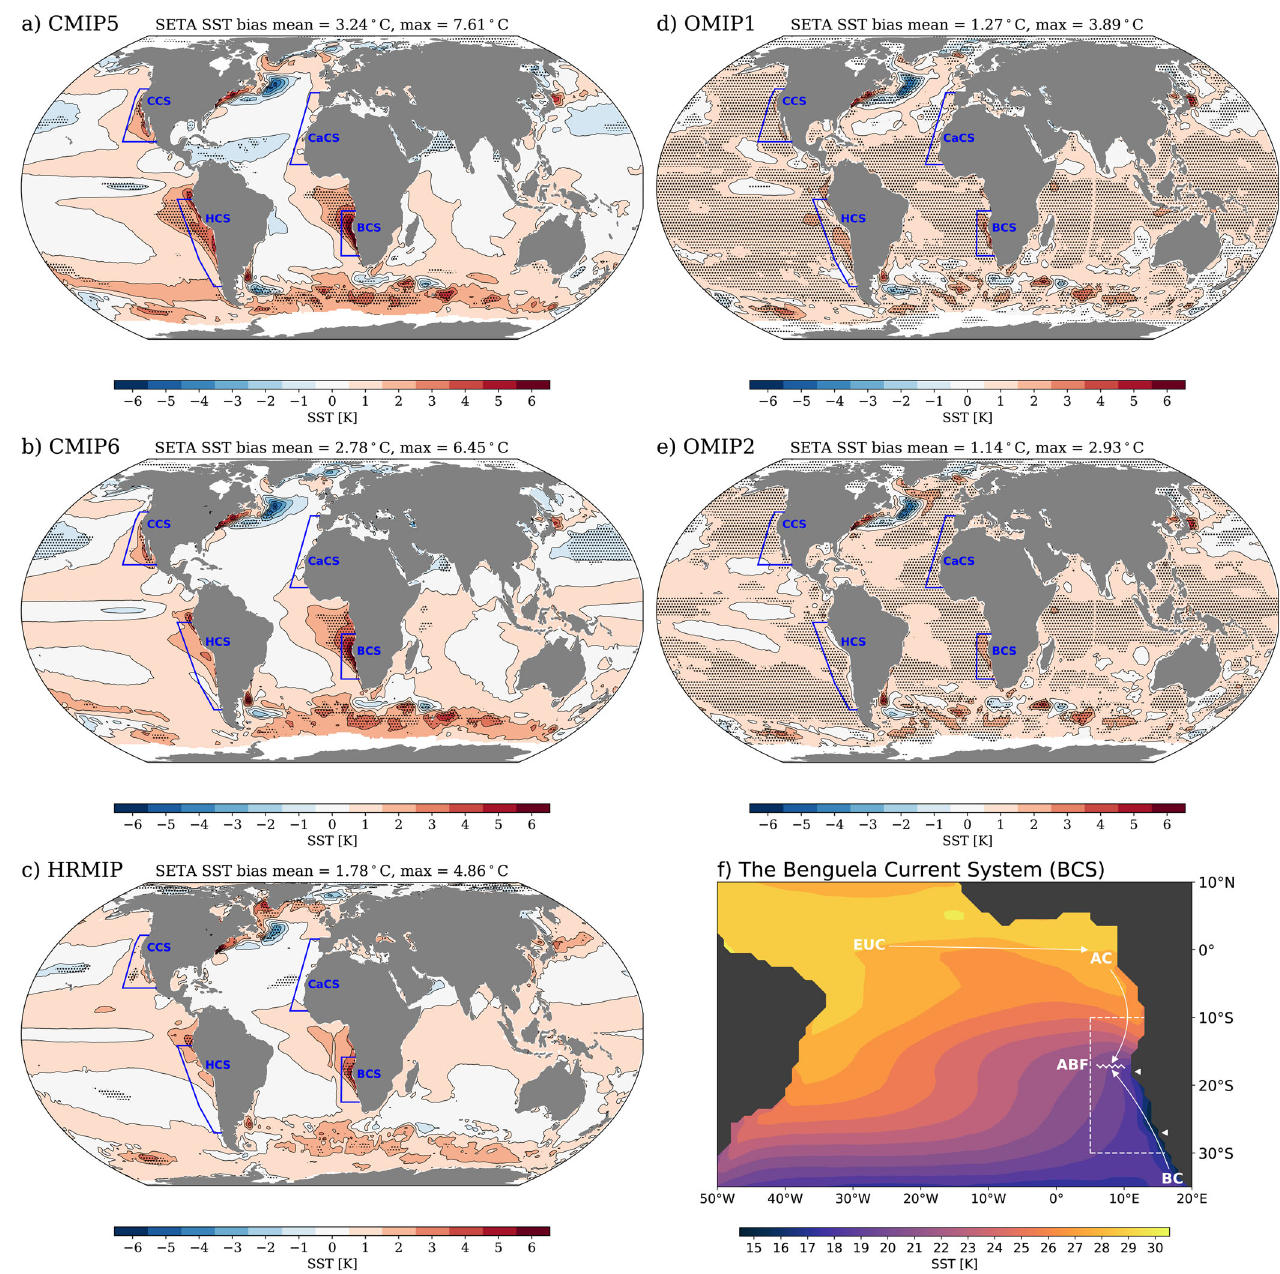
Fig. 1 Time-mean (1985 – 2004) SST bias in all CMIP MMMs. SST bias for ( a ) CMIP5, ( b ) CMIP6, ( c ) HighResMIP, ( d ) OMIP1 and ( e ) OMIP2 MMM relative to OISST. Every contour represents an SST bias of 1 ∘ C. Black dots show regions where all models in each MMM agree on the sign of the bias. The blue colored areas approximately delimit EBUS: the California Current System (CCS), the Canary Current System (CaCS), the Humboldt Current system (HCS) and the Benguela Current System (BCS). The main features of the BCS are sketched in ( f ) superimposed on the time-mean observed SST from OISST: the Equatorial UnderCurrent (EUC), the poleward Angola Current (AC), the equatorward Benguela Current (BC) and the Angola-Benguela Front (ABF) within the SETA region (dashed white